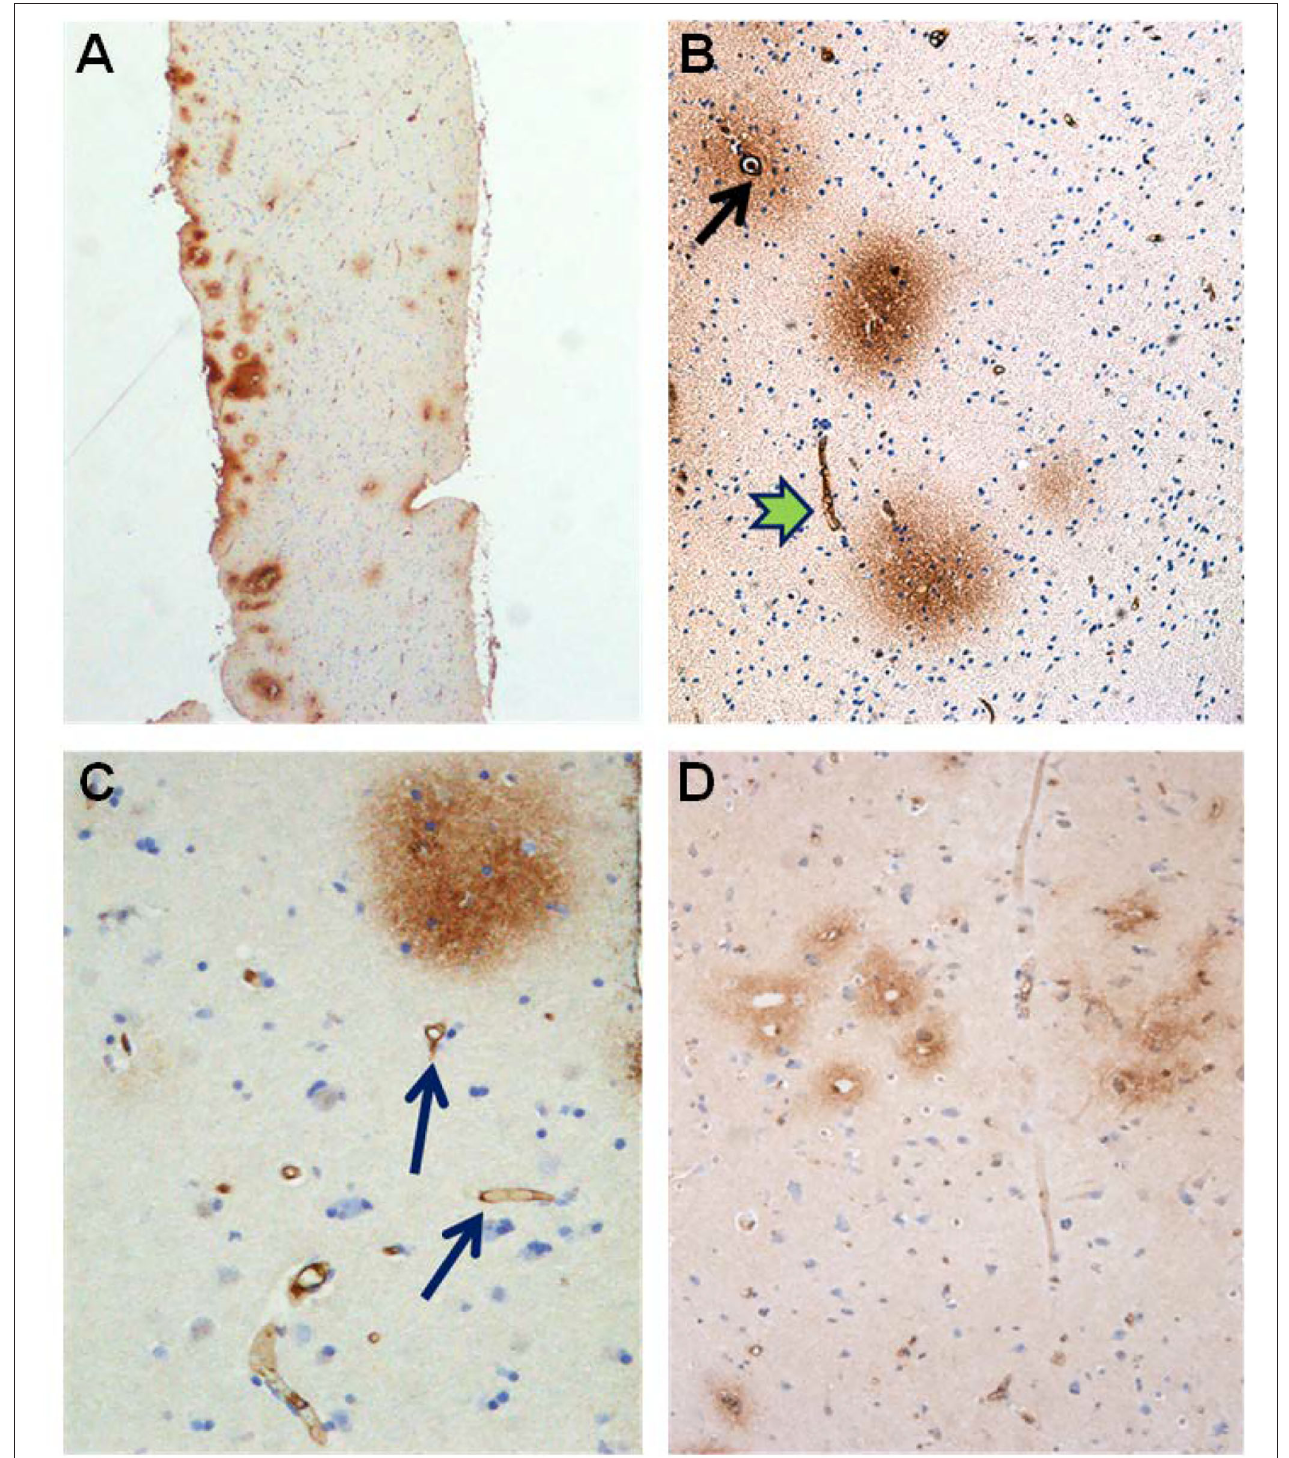
FIGURE 9 | Evidence of BBB dysfunction in IIH subjects. (A) The cerebral cortex biopsies comprised cortex tissue that was dissected and fixed by immersion within minutes to achieve best possible preservation. Extravasations of blood products were revealed by immunohistochemical demonstration of both fibrin and fibrinogen, i.e., the blood proteins detected by the used antibody. (B) Leakage from a small blood vessel (black arrow) in the center of extravasated fibrin(ogen). Note the vessel wall at the top is retaining blood proteins. (C) Fibrin (ogen) is demonstrable both extravasated (upper right corner) and in the walls of small brain vessels (arrow). (D) A cluster of small blood vessels is surrounded by leaked fibrin